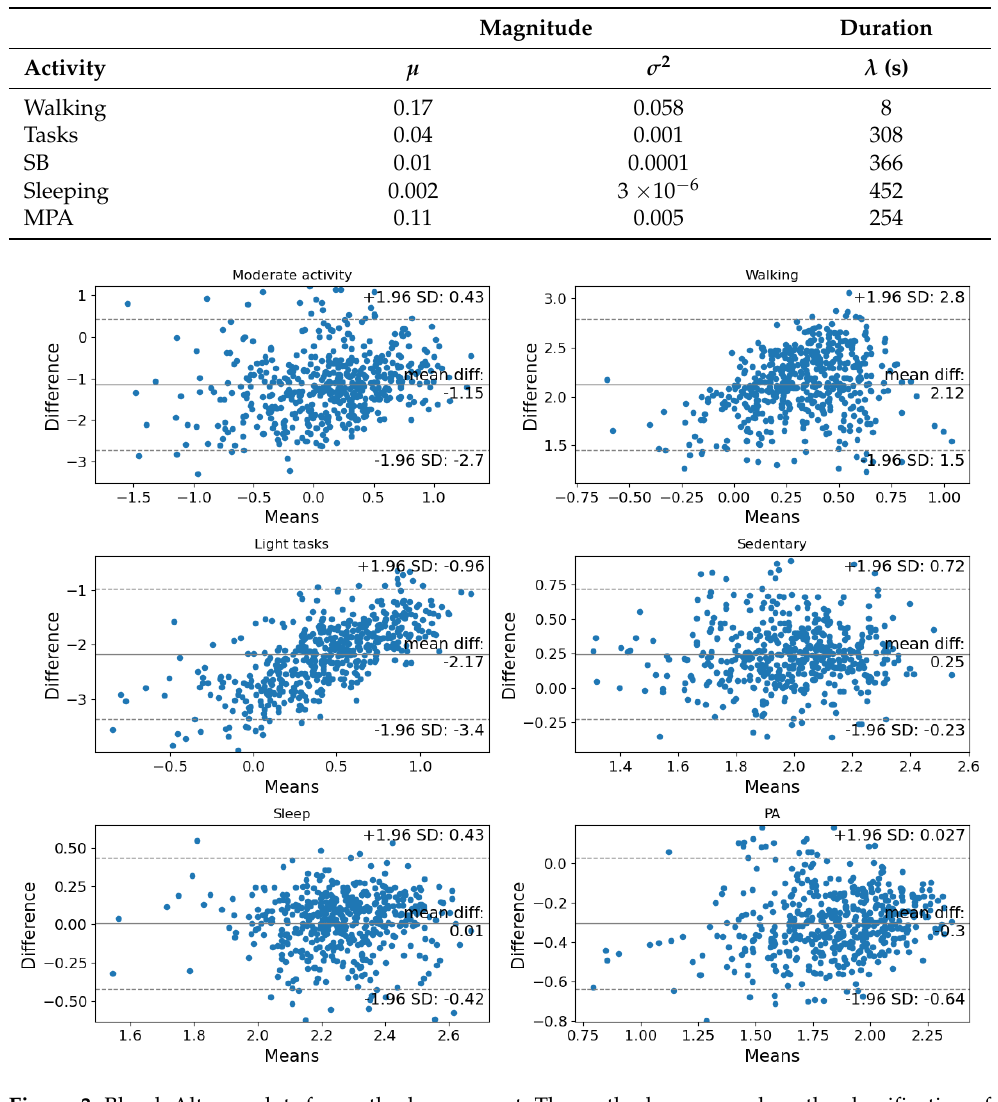
Table 6. Acceleration magnitude and duration for each activity estimated by the HSMM.